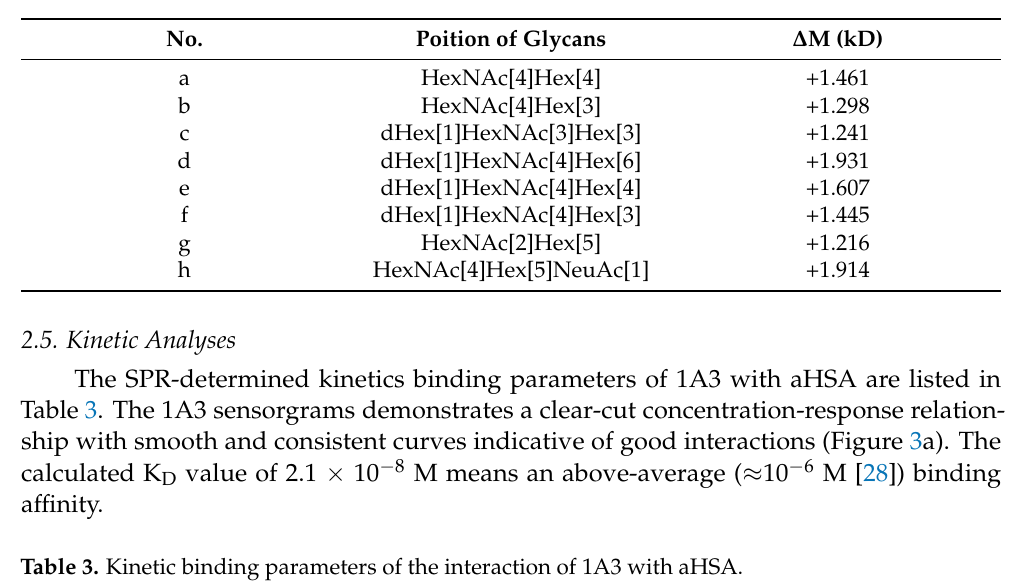
Table 2. Position, type and mass of glycans in the V L region of 1A3 mAb.